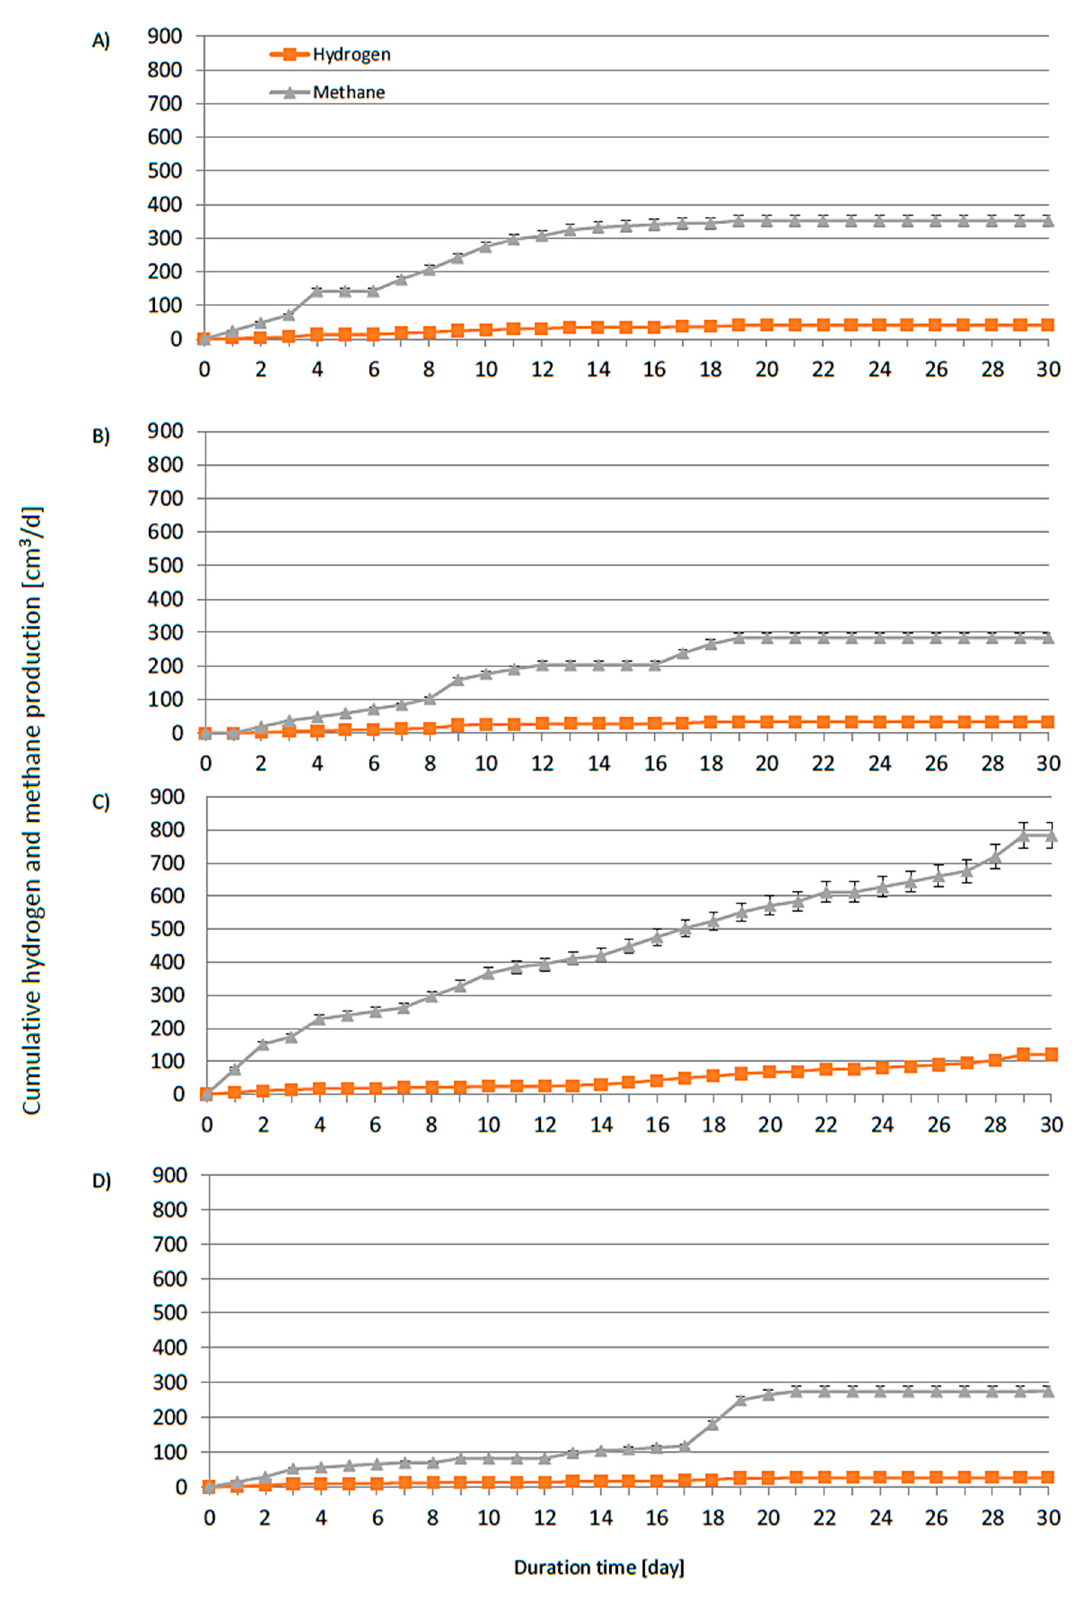
Figure 18. Daily average specific hydrogen and methane production from cotton hydrolyzed in AD systems (mesophilic conditions) with ( A ) H 2 SO 4 neutralized with NaOH, ( B ) H 2 SO 4 neutralized with KOH, ( C ) H 3 PO 4 neutralized with NaOH, and ( D ) H 3 PO 4 neutralized with KOH.